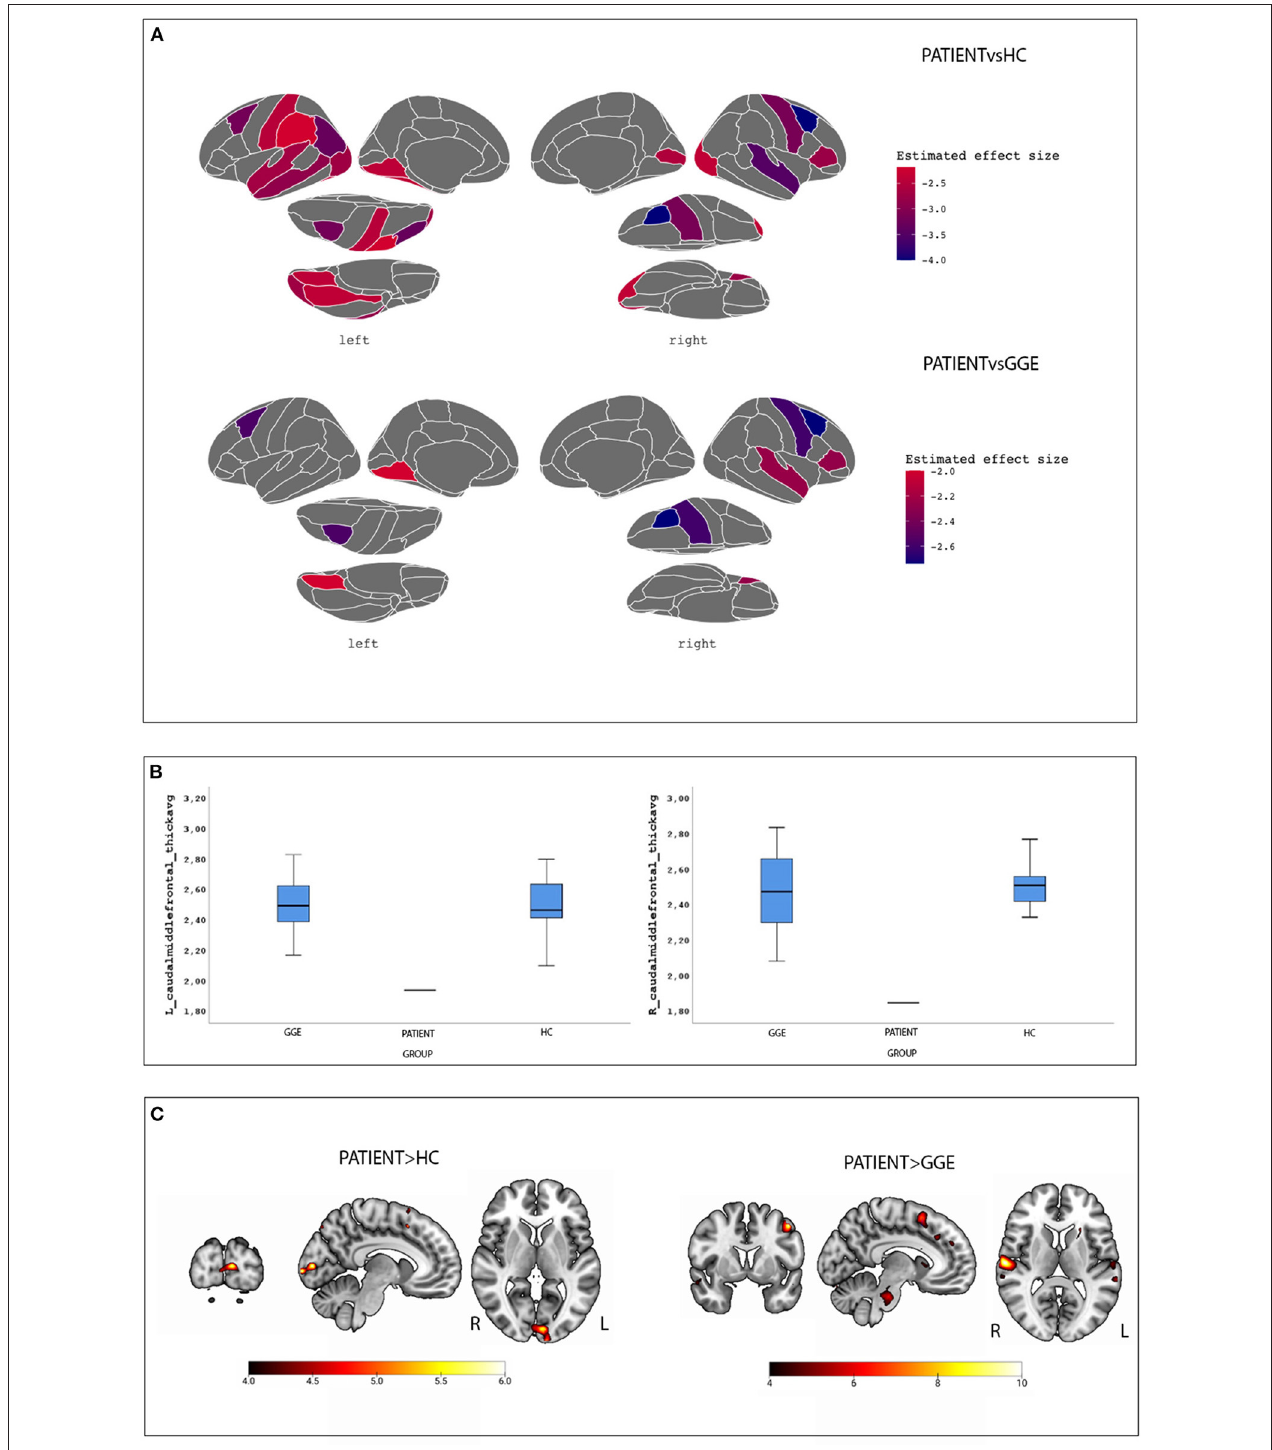
FIGURE 1 | Morphometric and Functional results. (A) surface brain templates depicting regions of cortical thinning in the proband compared to HC (top images) and GGE (bottom images). Brain statistics were displayed using the ggseg and ggseg3d packages integrated into the software R environment using the Desikan-Killiany cortical atlas (28). (B) Percentile distribution of cortical thickness for the left and caudal middle frontal gyri in the case compared to controls and GGE; see text for details. (C) BOLD maps related to the eye closure conditions in the patient compared to controls (left images) and GGE (right images). Results are overlaid into the MNI152 template as provided by the MRIcroGL